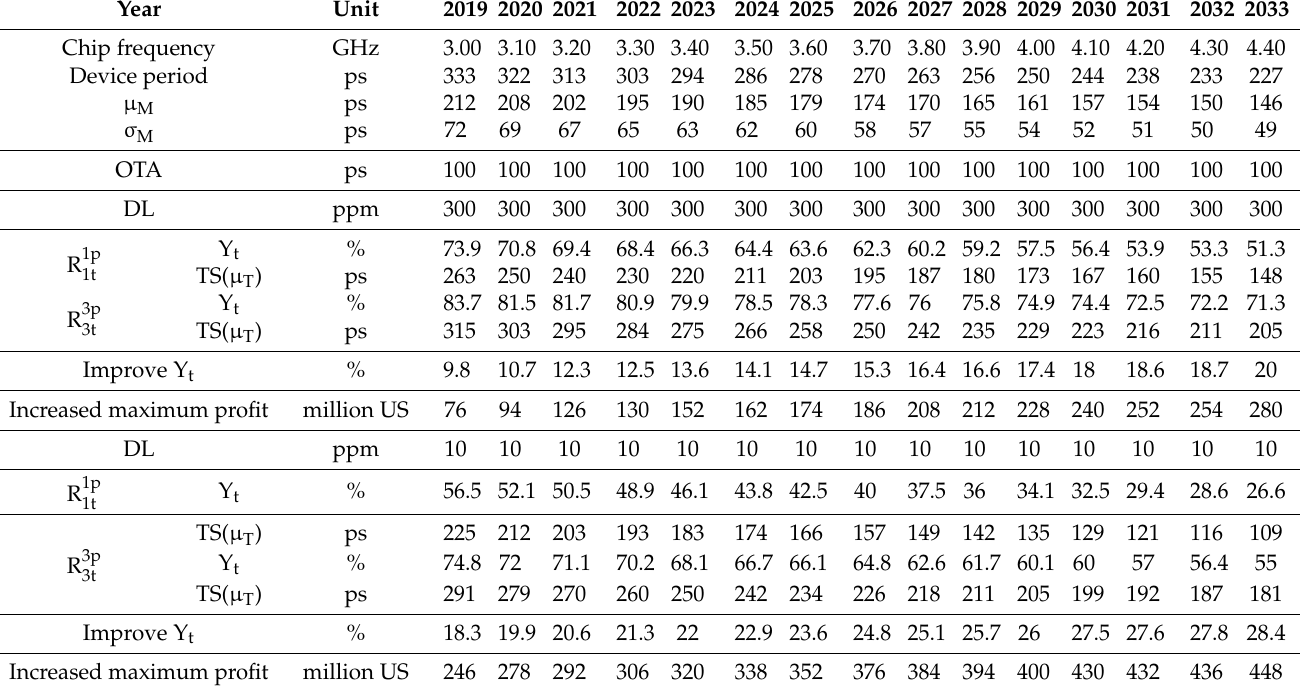
Table 3. Efficient test method for high-quality